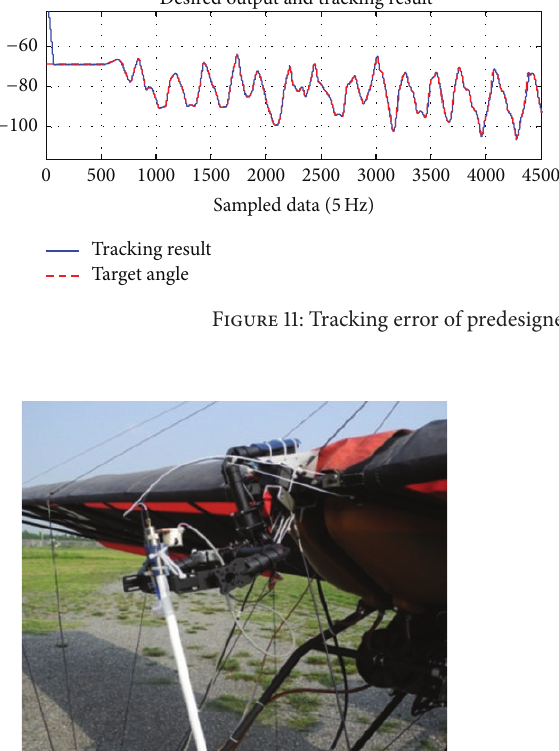
Figure 14: Test site for Sky-Net microwave air-bridging at 440 m